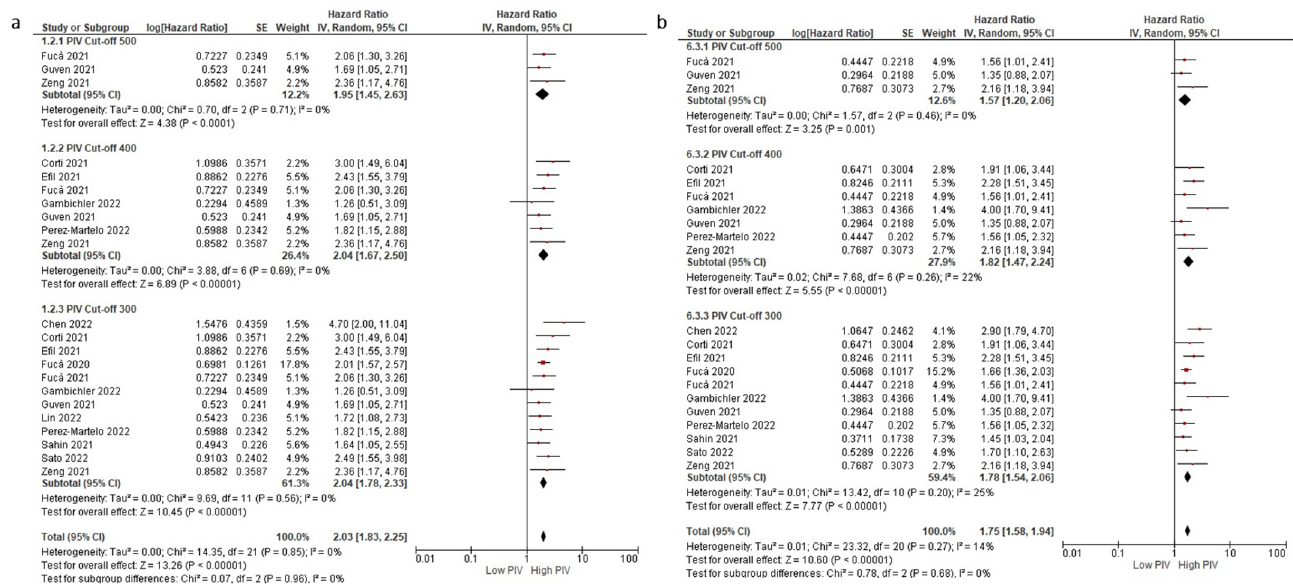
Figure 4. Subgroup analyses according to PIV cut-off in OS ( a ) and DFS/PFS ( b ). Lines ( ○ ) indicate 95% CIs. Diamond ( ♦ ) indicates the pooled effect size.